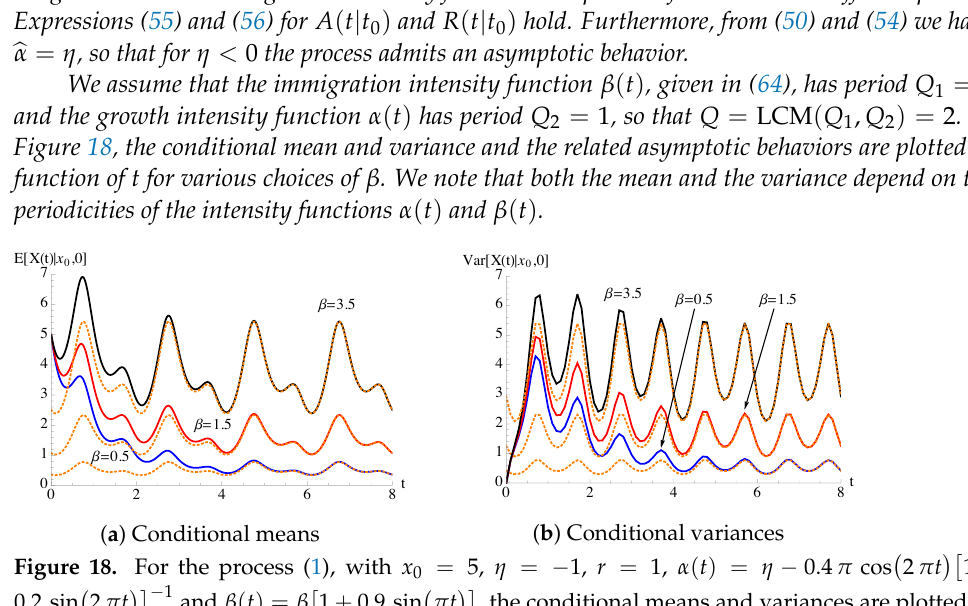
Figure 18. For the process (1), with x 0 = 5, η = − 1, r = 1, α ( t ) = η − 0.4 π cos (cid:0) (cid:1)(cid:3) − 1 0.2 sin 2 π t and β ( t ) = β function of t for various choices of β . The dotted functions indicate the related asymptotic means and